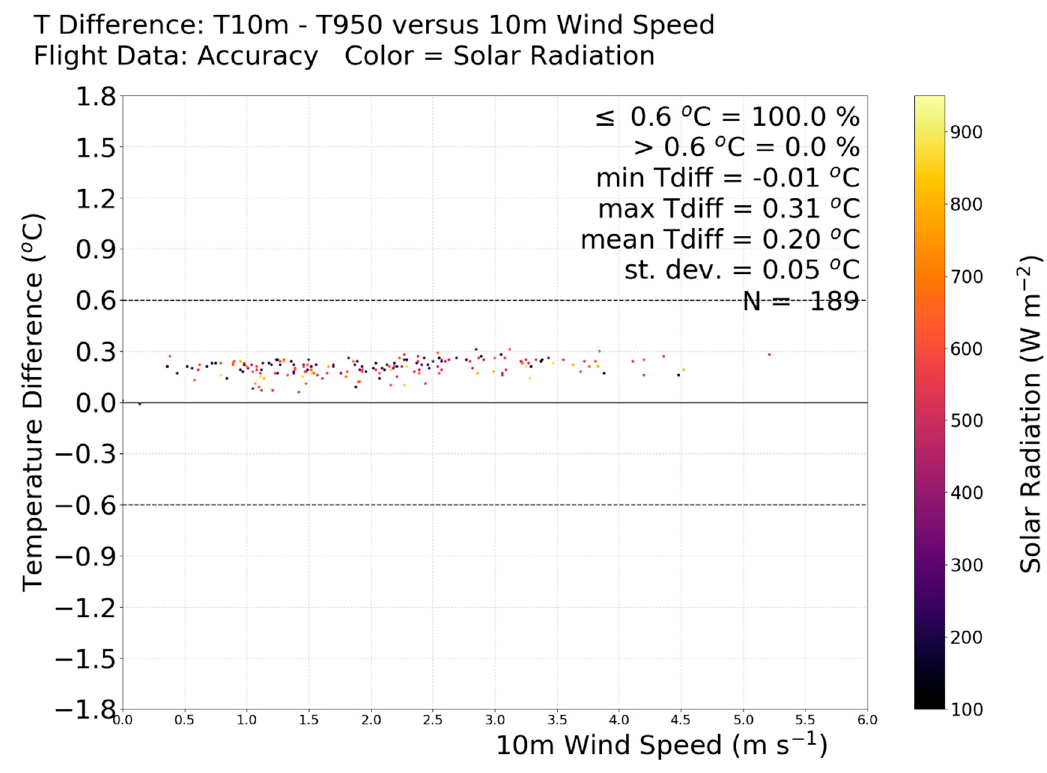
Figure 3. Temperature difference between the 10 m and 9.5 m temperature sensors (T 10 m –T 9.5 m ) on the Mesonet tower as a function of 10 m wind speed (x axis, m s − 1 ) and solar radiation (color, W m − 2 ).